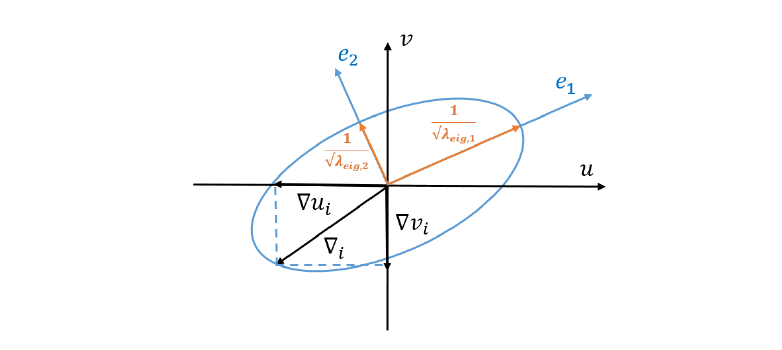
Figure 3. Internal reliability ellipse for a two-dimensional fault. Shown are the major and minor axes of the ellipse (in orange), and their lengths are detected by probability γ , ranges between these two